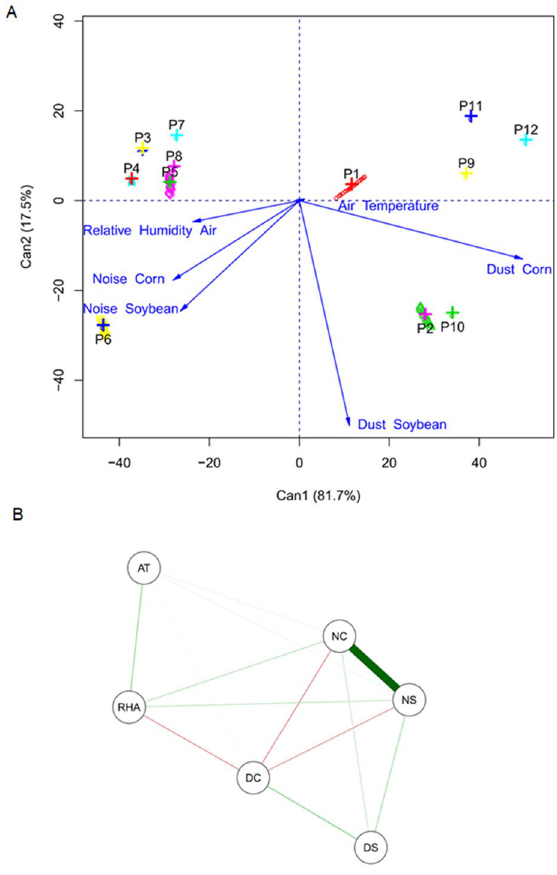
Figure 8. Canonical variables ( A ) for noise in corn (NC), noise in soybean (NS), dust in corn (DC), dust in soybean (DS), relative air humidity (RHA) and air temperature (AT) evaluated in different processing conditions (P). Person’s correlation network ( B ) between the variables noise in corn (NC), noise in soybean (NS), dust in corn (DC), dust in soybean (DS), relative air humidity (RHA) and air temperature (AT) evaluated in different processing